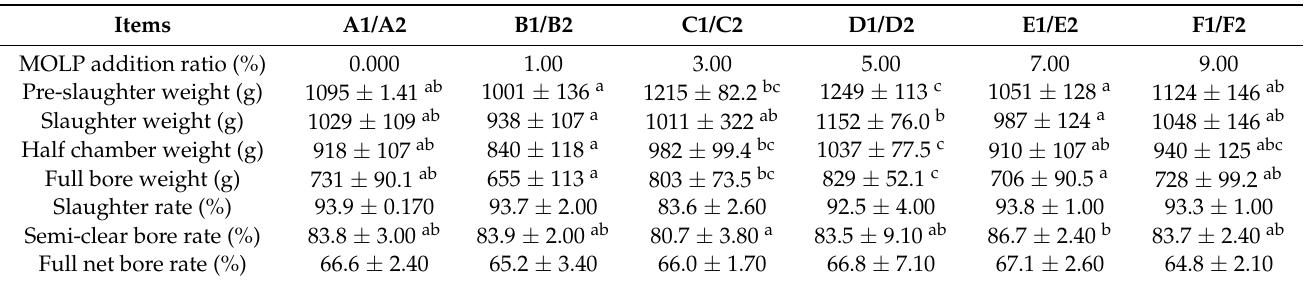
Table 4. Effects of Moringa oleoresin leaf power on the carcass characteristics of broiler chicken fed an 8-week